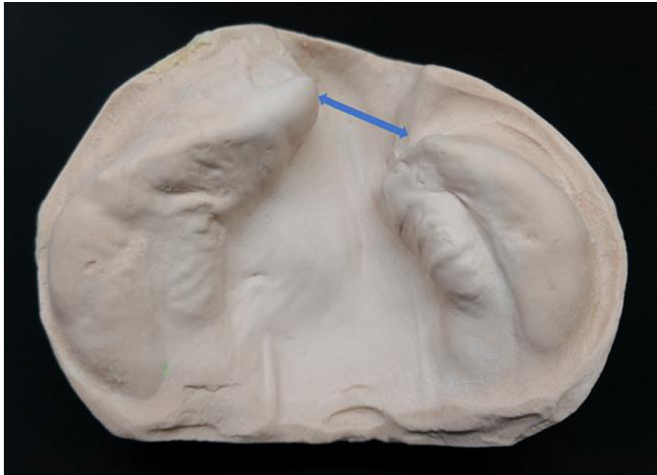
Figure 4. Points of the measurement of cleft jaw width. Blue line, cleft jaw width.